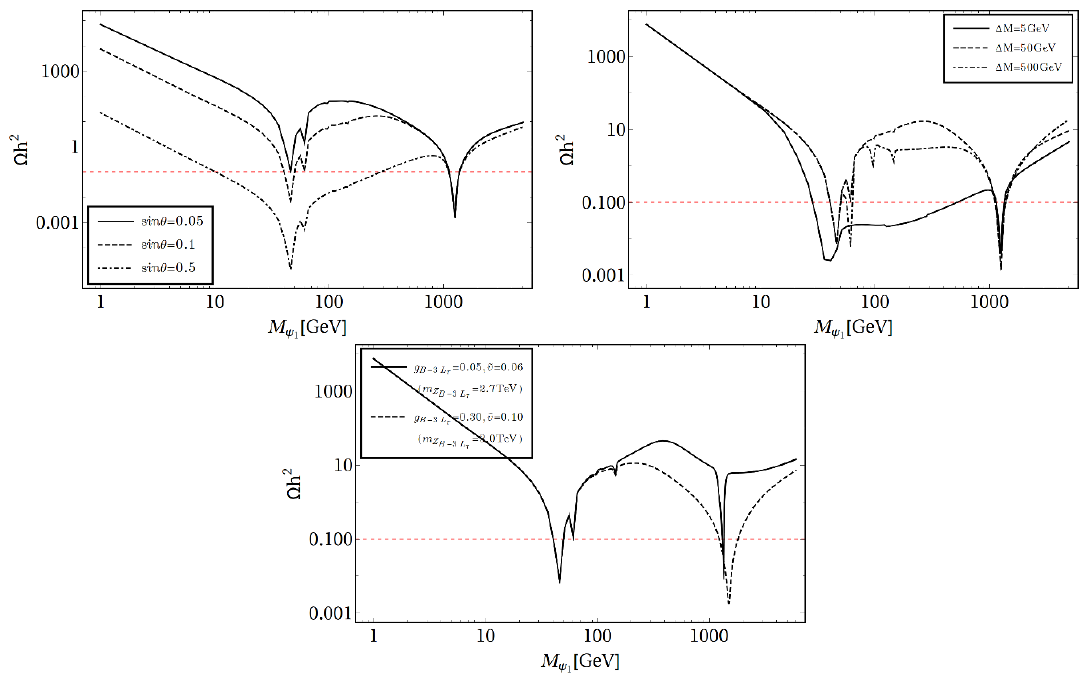
Figure 3 . Top: variation of relic abundance of 1 with M sin (cid:18) : f 0 : 05 ; 0 : 1 ; 0 : 5 g keeping (cid:1) M = 50 GeV (cid:12)xed (top left) and for di(cid:11)erent choices of (cid:1) M : f 5 ; 100 ; 500 g GeV keeping sin (cid:18) = 0 : 1 (cid:12)xed (top right). g B (cid:0) 3 L both of these plots. Bottom: variation of relic density with M g B (cid:0) 3 L : f 0 : 2 ; 0 : 3 g for (cid:12)xed value of ~ v = 1 : 3, (cid:1) M = 50 GeV and sin (cid:18) = 0 : 1. In all three plots, the (cid:28) horizontal dashed line (red coloured) corresponds to the central value of Planck limit on DM relic